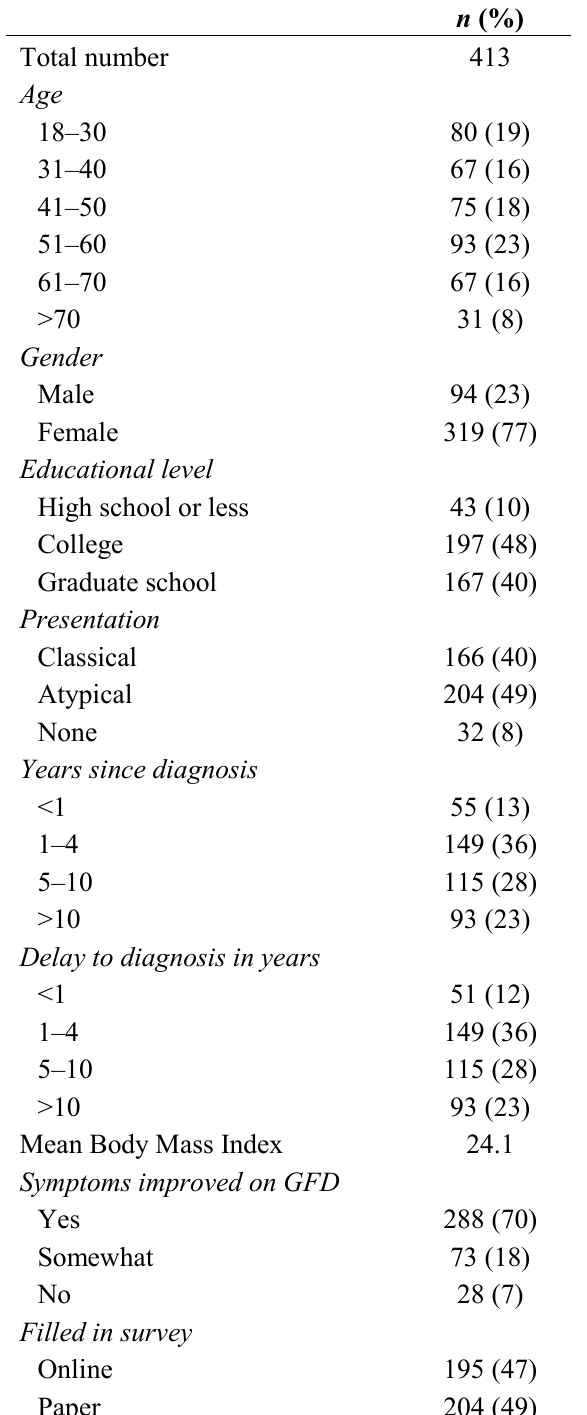
Table 1. Patient